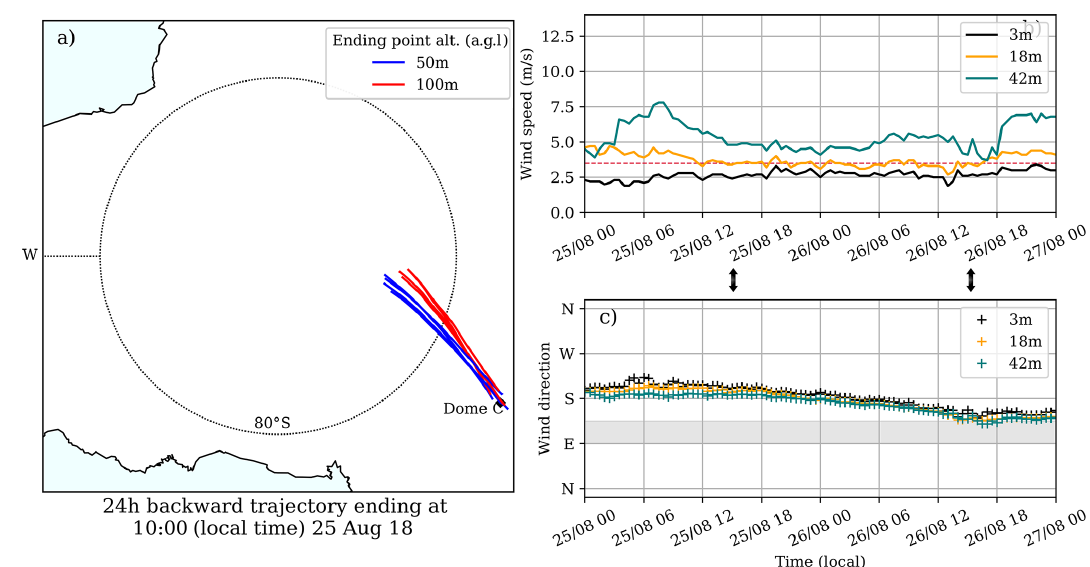
Figure 7. Same as Fig. 3 but for Event